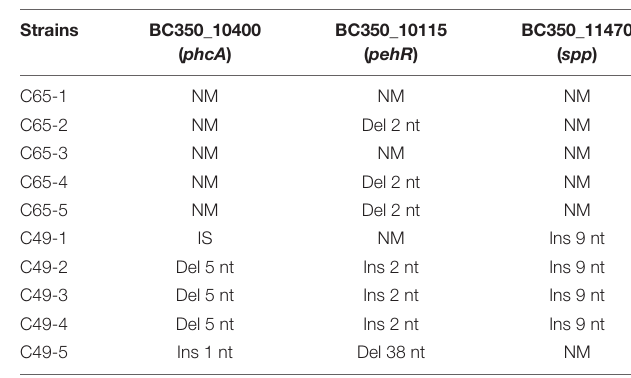
TABLE 1 | Gene variation after